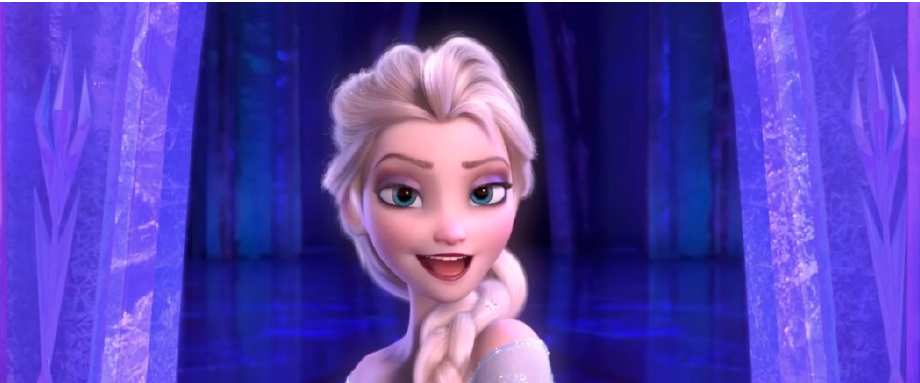
Figure 7. ‘The cold never bothered me anyway’ (Walt Disney Animation Studios 2013a). And with that, she turns and slams the door, disappearing into her Ice Palace. The final shot is of a door (Figure 8):